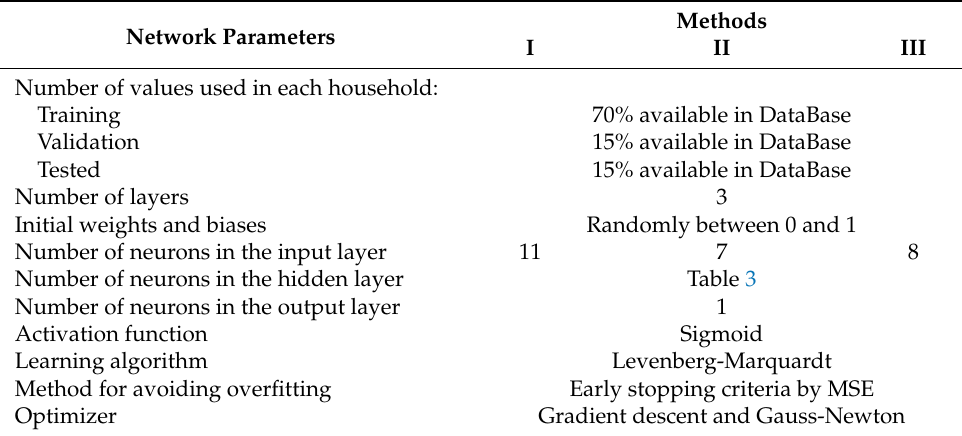
Table 2. ANNs network parameters. Network Parameters